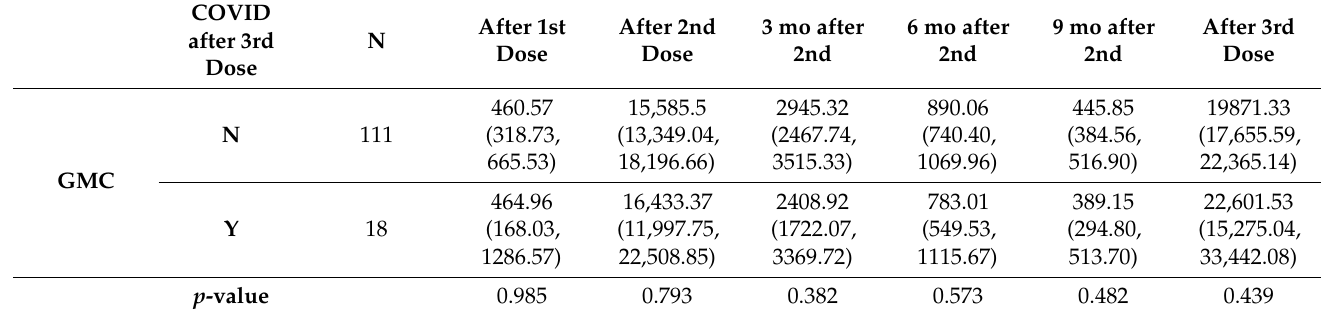
Figure 3. Boxplots of antibody levels (logarithmic scale) of subjects infected 2 – 3 months after the booster dose versus those not infected. No significant differences were observed.